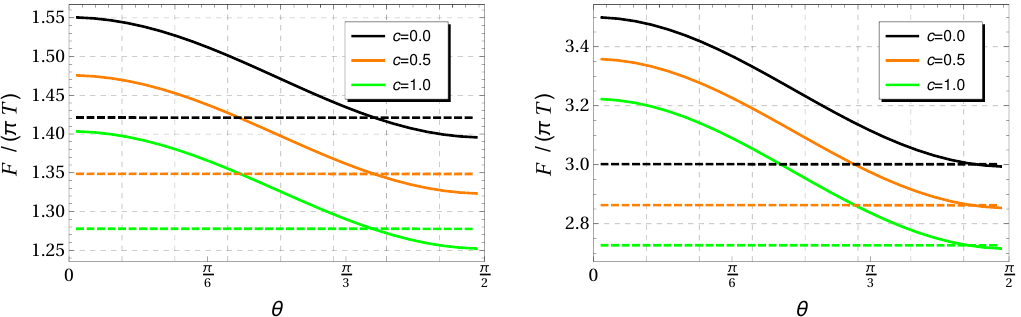
Figure 15 . The drag force for di(cid:11)erent values of the non-conformal deformation parameter c at v = 0 : 7 (left) and v = 0 : 9 (right). The horizontal lines are the drag force for a= ( (cid:25)T ) = 0 and the curved lines are the drag force for a= ( (cid:25)T ) = 1 : 5. The critical value (cid:18) c does not depend on c but on the absolute value of the velocity v